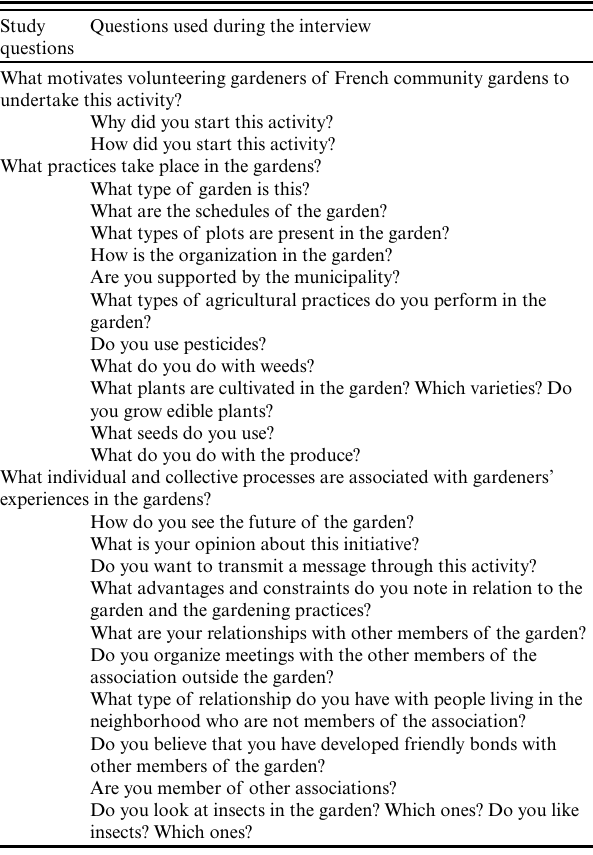
Table 2 . Questions used during the interviews and their